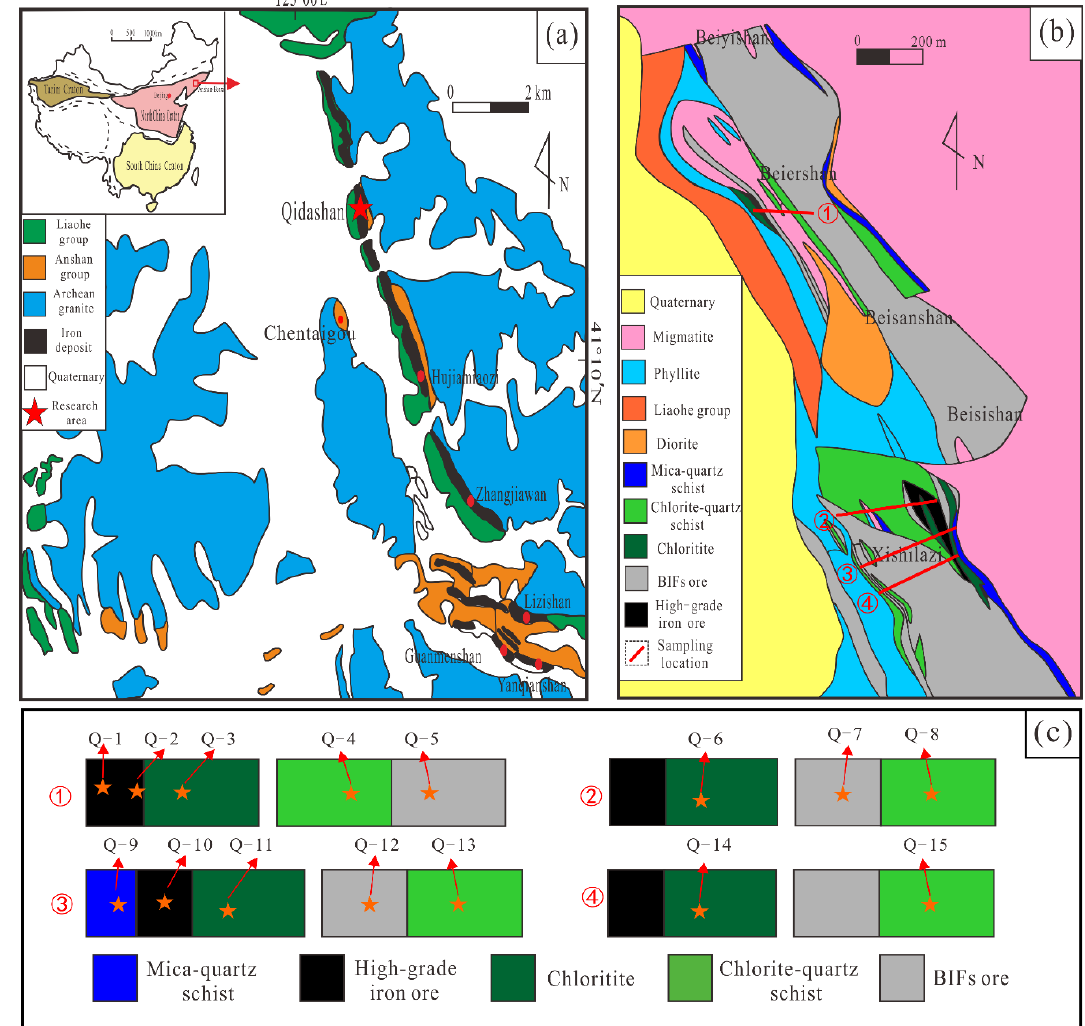
Figure 5. ( a ) Simplified regional geological map of Anshan area, ( b ) geological map of Qidashan Iron Deposit, and ( c ) sketch diagram of sampling.